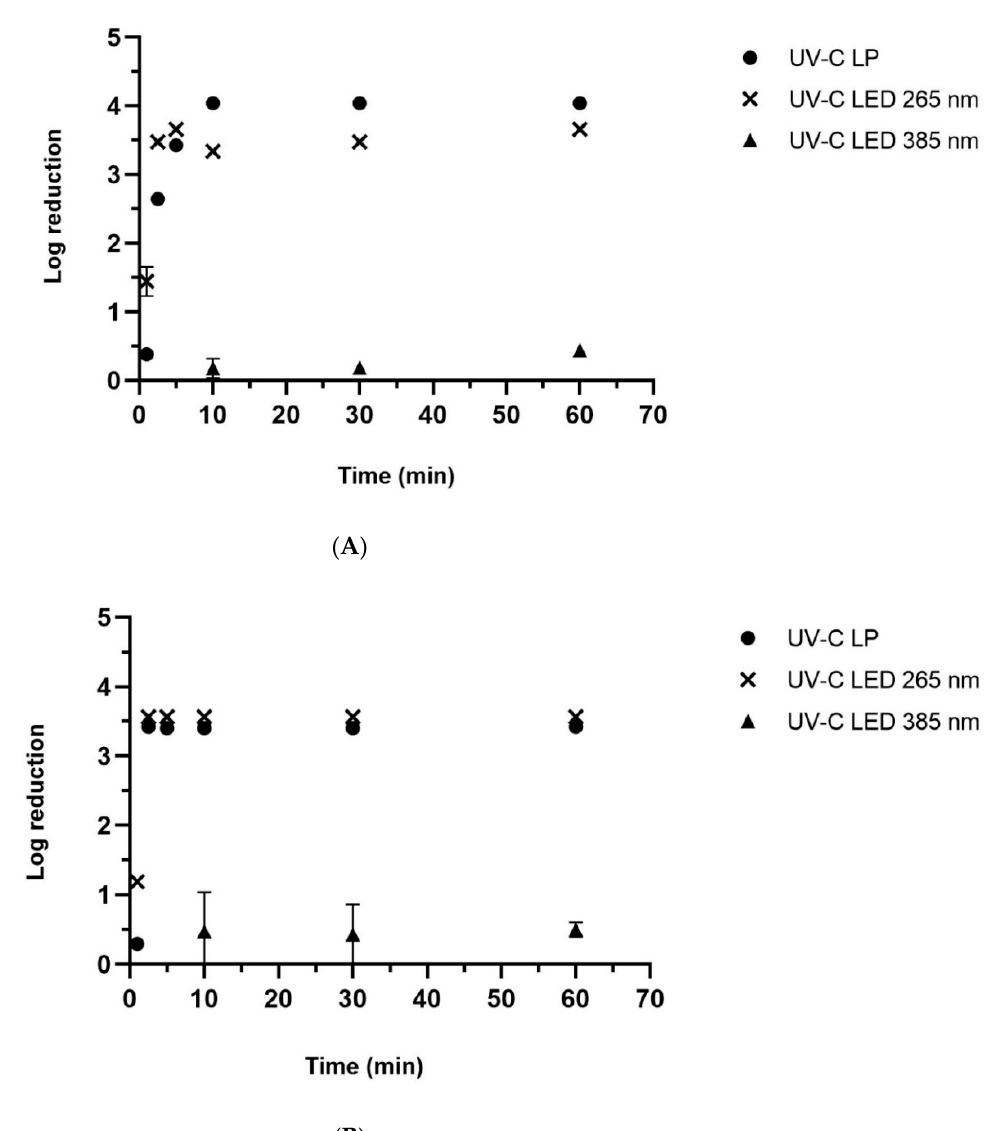
Figure 2. Log reduction of total coliforms ( A ) and E. coli ( B ) as a function of irradiation time on surface water. Error bars represent duplicate results.